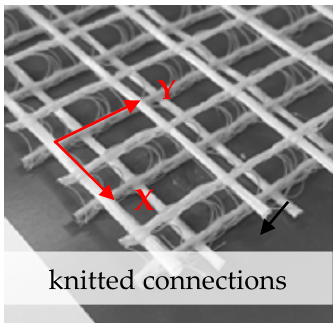
Figure 2. 3D, knitted textile.